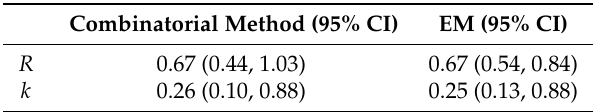
Table 2. Estimation and CI of the reproduction number R and dispersion parameter k based on the conbinational method and the expectation-maximization (EM)